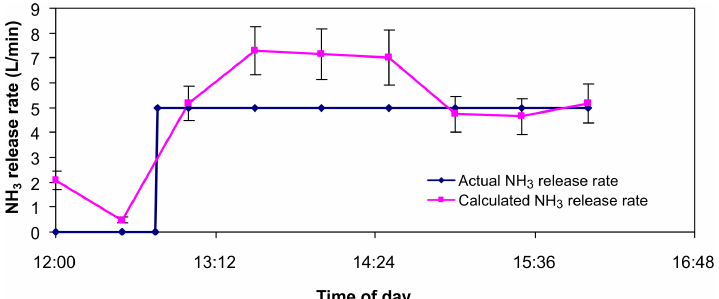
Figure A4. Controlled release from 25 × 25m grid (source 3). The calculated release was the average of bLs WindTrax calculations using line-averaged mole fraction measurements from two NH 3 lasers.